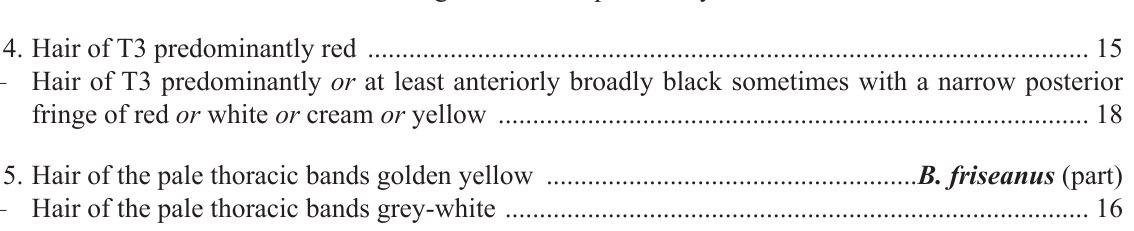
Hair of T2 black, side of thorax black, wings nearly clear (Caucasus) .............................................. 10. Long hair of the face at the antennal base with an obvious patch dominated by long pale grey or pale yellow hair, which in its centre often has few or no black hairs intermixed ...................................11 Long hair of the face mostly black, sometimes with a minority of long yellow or grey hair 11. Hair of T2 anteriorly brown, T3‒5 bright orange-red .................. B. friseanus Skorikov, 1933 (part) – Hair of T2 anteriorly grey or yellow, T3 anterior half at least black, T4‒5 orange-red or pale orange 12. Hair of T2 posteriorly with at least a very narrow fringe of black hair, T3 predominantly black, T4‒5 uniformly pale orange-red or pale orange or cream or white ............................................................ Hair of T2 entirely pale, posteriorly without any black hair, T3 black anteriorly but posteriorly usually with a broad pale fringe, T4‒5 orange-red sometimes with paler